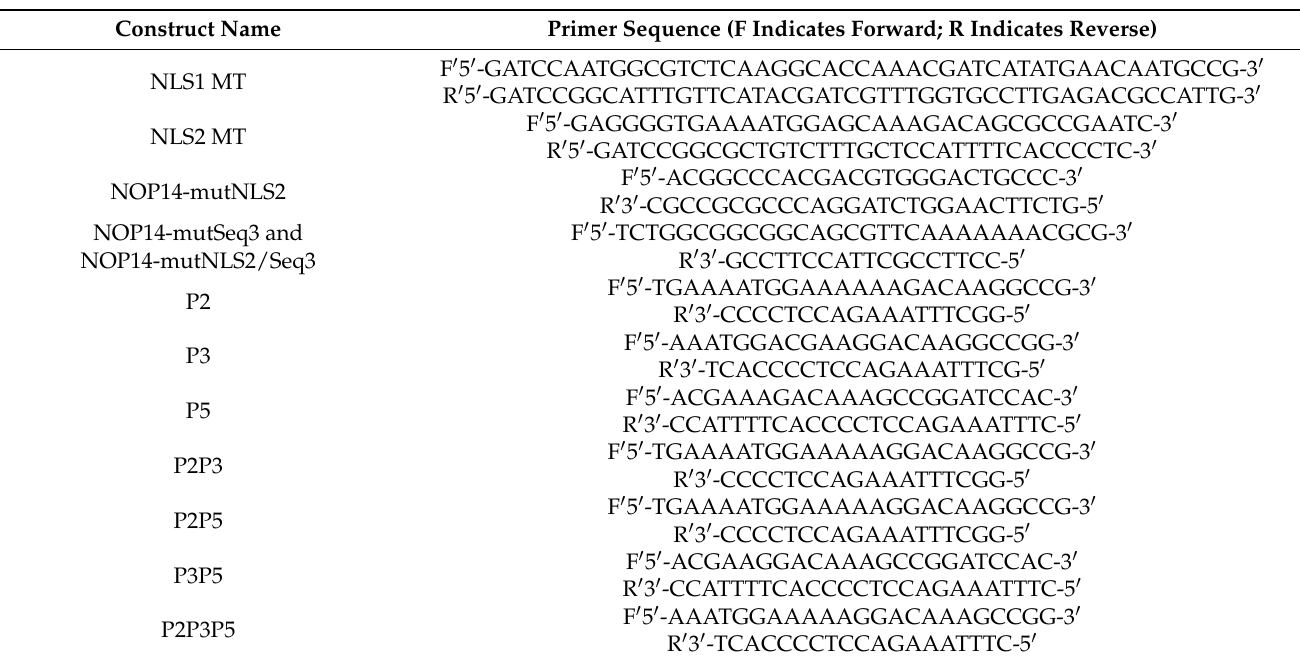
Table 1. Primers used in this